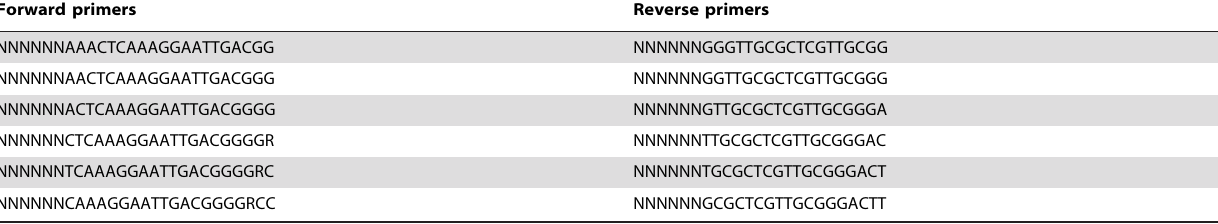
Table 5. Primers used to amplify 16S